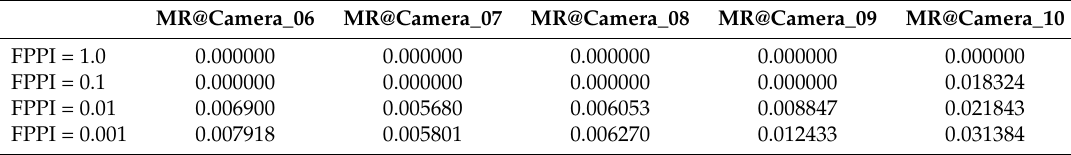
Table 13. Accuracy table @ Cameras_06–10, informed-filters, some viewpoints.